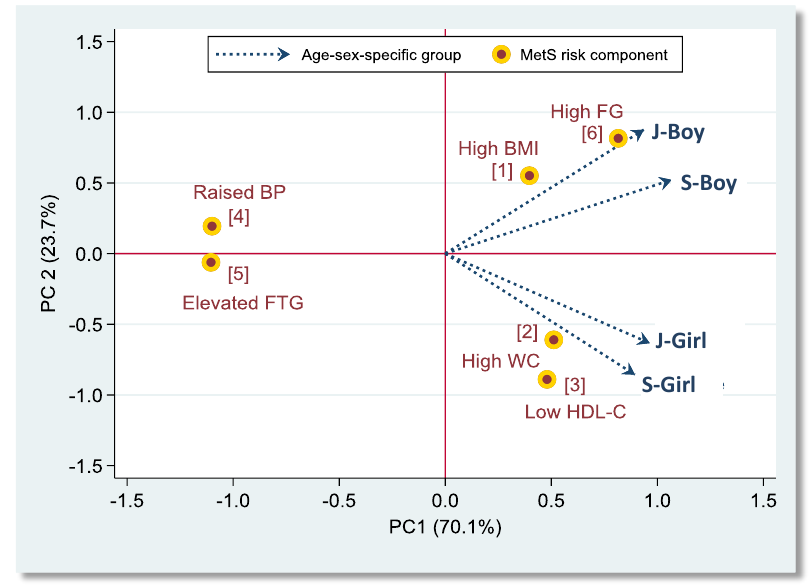
Figure 1. Two-dimensional biplot for risk components of adolescent metabolic syndrome (MetS) and gender-age-specific adolescent groups. Note : Red circles denote six adolescent MetS-associated risk components defined by the TPA-IDF generalized criteria. Arrows denote four gender-age-specific adolescent groups (J-Boy, junior boys; J-Girl, junior girls; S-Boy, senior boys; S-Girl, senior girls). The percentages indicate the amount of variance accounted for by principal components PC1 and PC2. Total explained variance from the first two components is 93.8%.